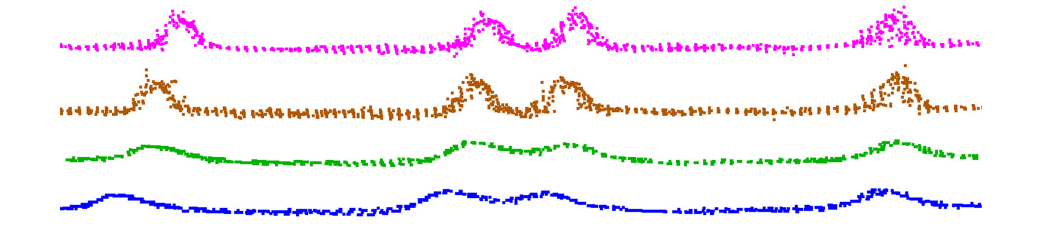
Figure 8. Presentation of each profile as shown in Figure 7: